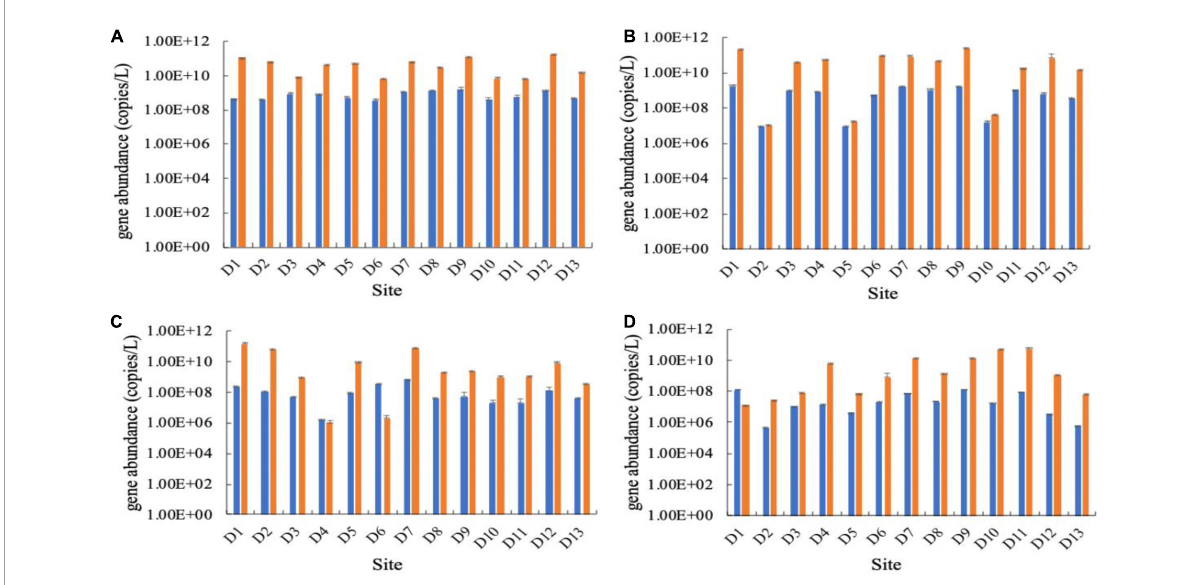
FIGURE2 Abundances of the cbbL (left, blue) and cbbM (right, orange) genes in the Huixian karst groundwaters. (A) Winter (201801); (B) Spring (201804); (C) Summer (201807); (D) Autumn